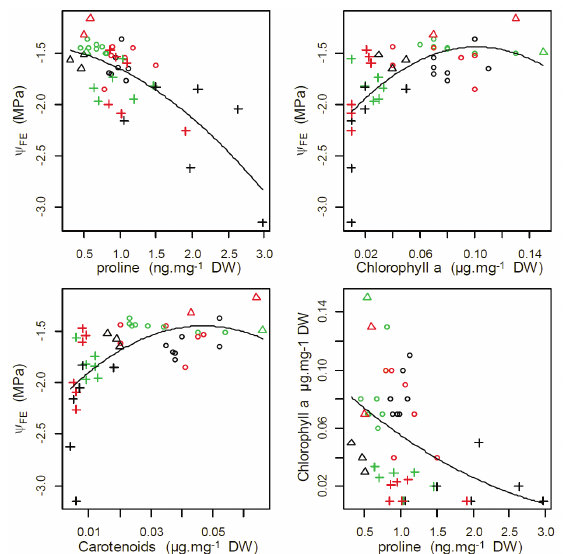
Fig. 7 ­ Regressions between laboratory variables. Colors repre­ sent condition of fruit: green for healthy fruit (HF), red for red fruit (RF), and black for sunburnt fruit (SBF). Symbols represent days after full bloom (DAFB): ○ for 91; Δ for 99; + for